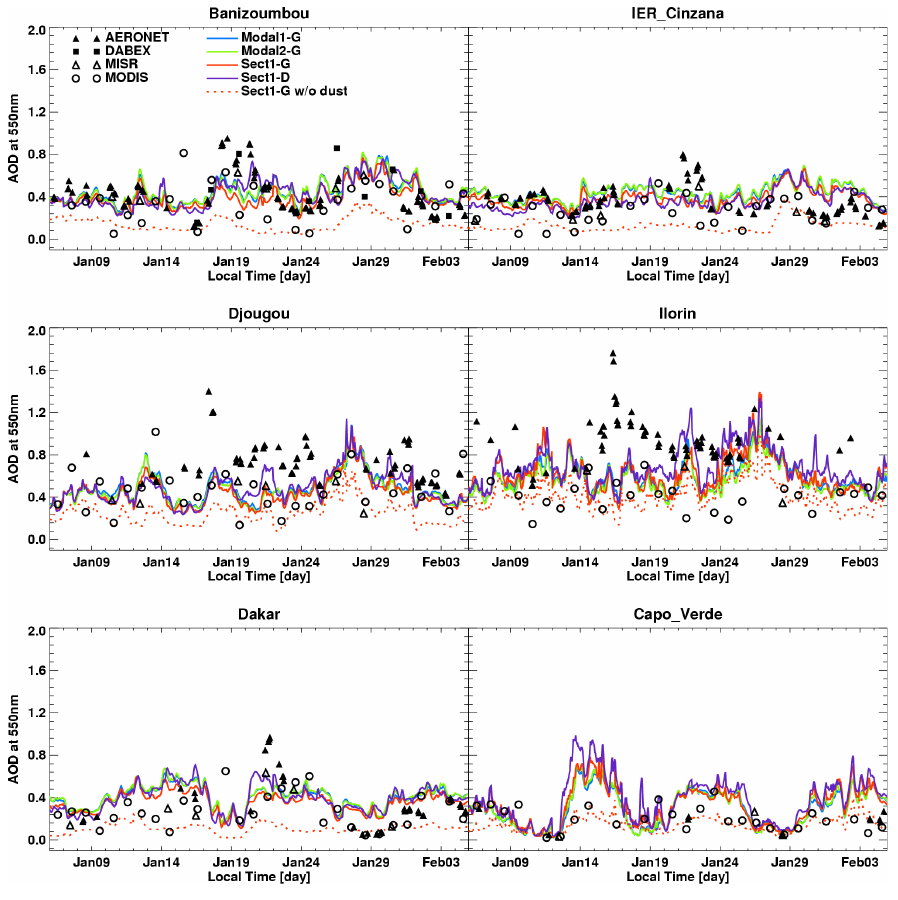
Fig. 8. Hourly AOD at 550nm from the AERONET measurements, MISR and MODIS retrievals, DABEX aircraft measurements (Bani- zoumbou only) and the corresponding WRF-Chem simulations in different cases during the simulation period at the six AERONET sites over North